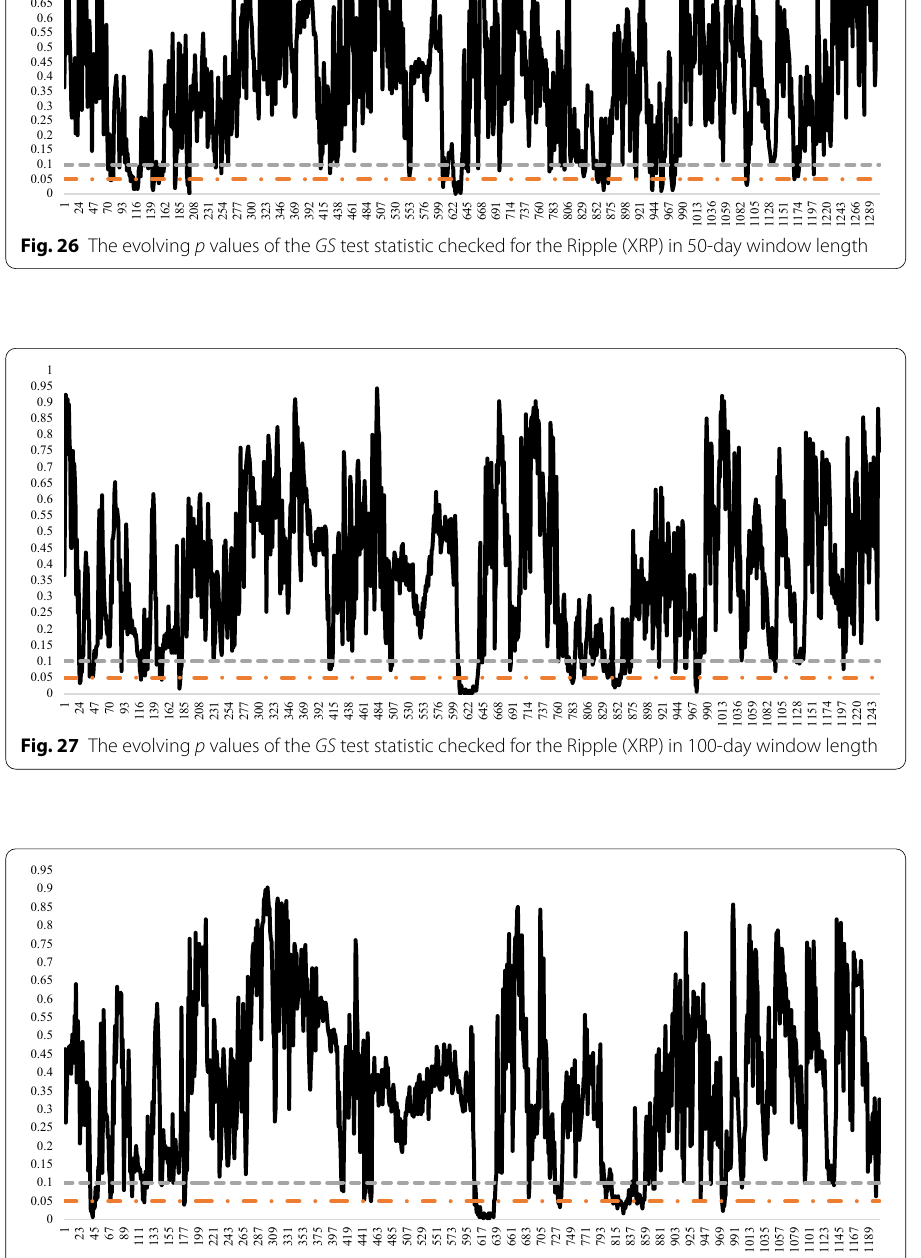
Fig. 28 The evolving p values of the GS test statistic checked for the Ripple (XRP) in 150-day window